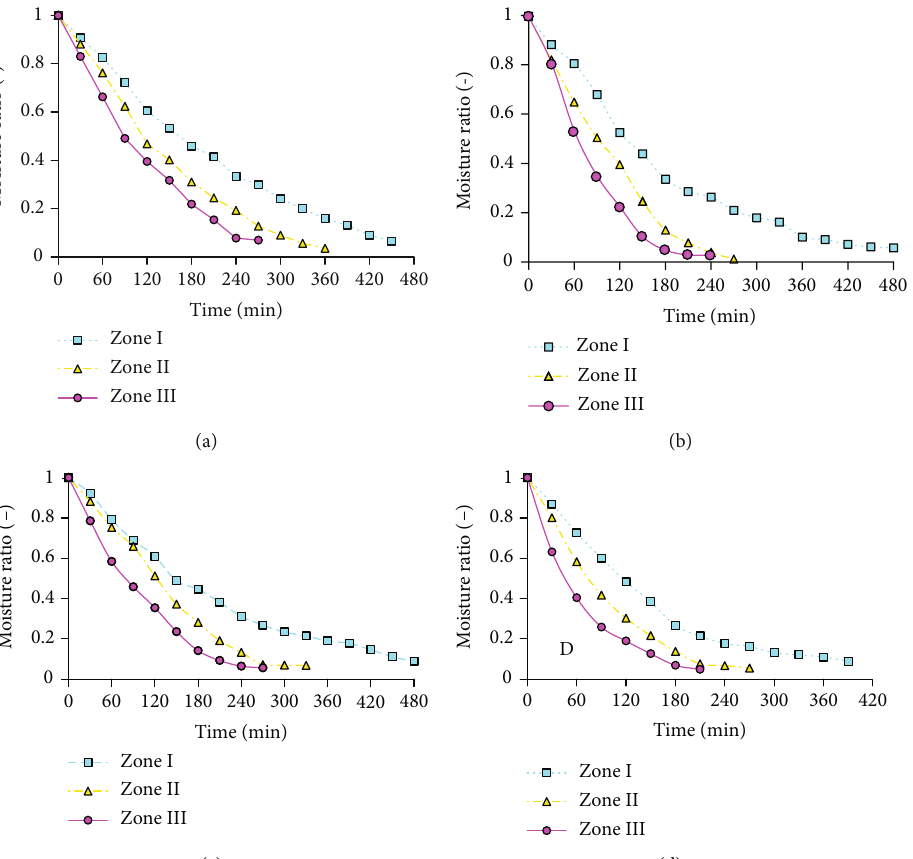
Figure 3: Moisture ratio of pumpkin slices versus time at di ff erent dryer zones for control (a), 1% citric acid solution for 20 minutes (b), 2% salt solution for 20 minutes (c), and blanched in 1% salt solution at 65 ° C for 2 minutes (d). Table 3: E ff ective moisture di ff usivity ( D f ) of pumpkin slice at di ff erent zones and pretreatments. ef